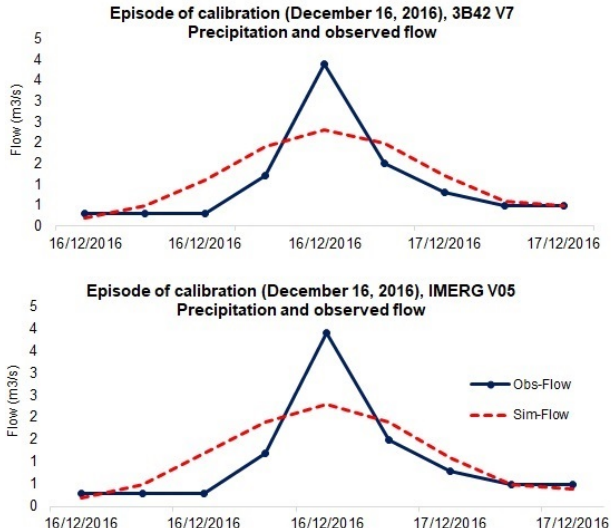
Figure 8. Calibration of the episode 16 December 2016, using 3B42V7 and IMERG V05 rainfall products and observed runoff data as input.